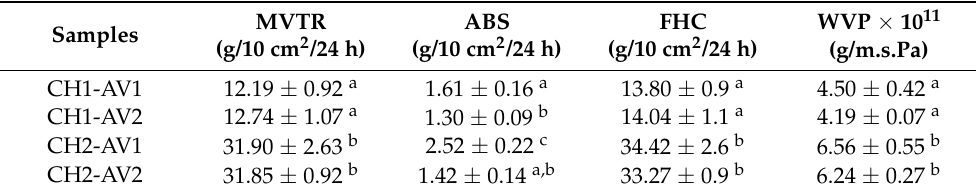
Table 2. Barrier properties—moisture vapor transmission rate (MVTR), absorption (ABS), fluid handling capacity (FHC), and water vapor permeation (WVP)—of the chitosan films for different concentrations of aloe vera